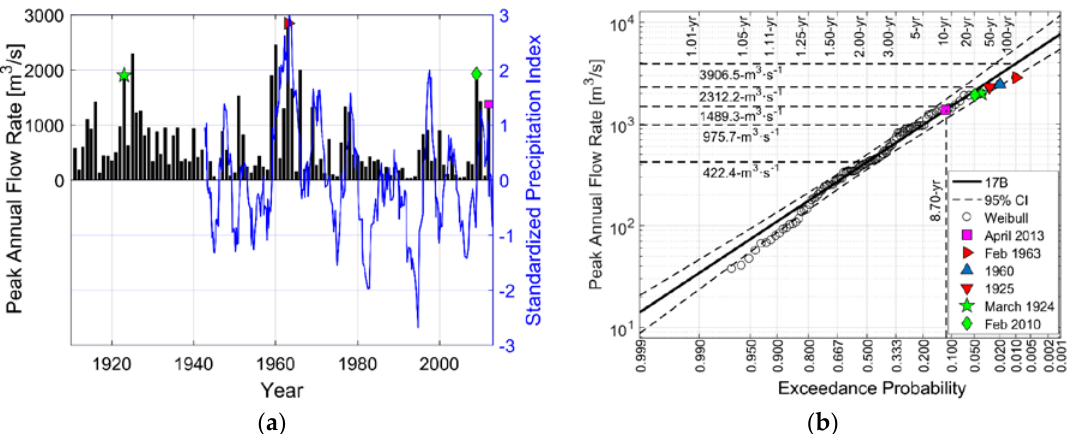
Figure 10. ( a ) Flood frequency distribution and relative magnitude of the Guadalquivir River floods at Marmolejo dam (after [1]); and ( b ) flood frequency analysis of streamflow records using PeakFQ [43]. Estimates of flood magnitudes for several recurrence intervals (1–200 years) are also given.